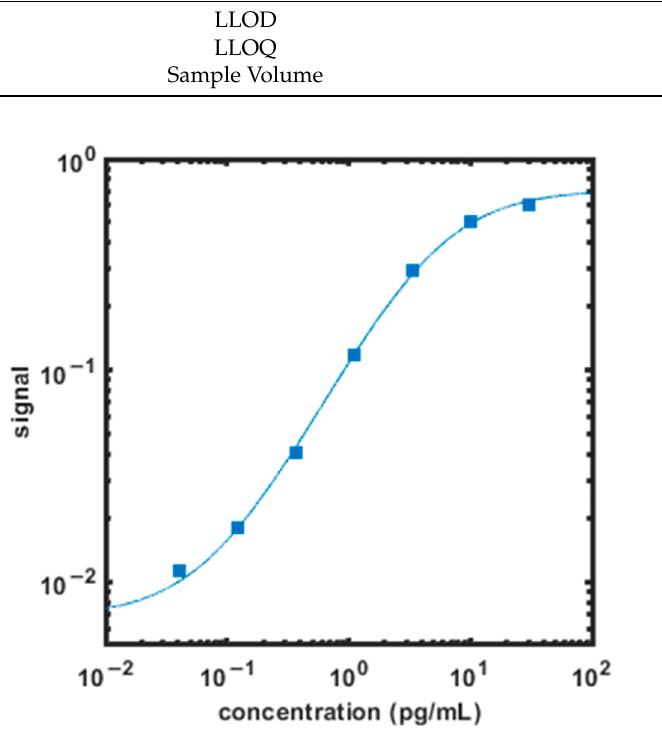
Figure 2. Example IL-6 assay calibration curve (squares). Assay signal is the fraction of beads contained in analyte-bound immunocomplexes. The solid line is a four-parameter logistic fit with 1/y 2 weighting. Table 2. Human IL-6 assay sensitivity. Table 3. Recovery and